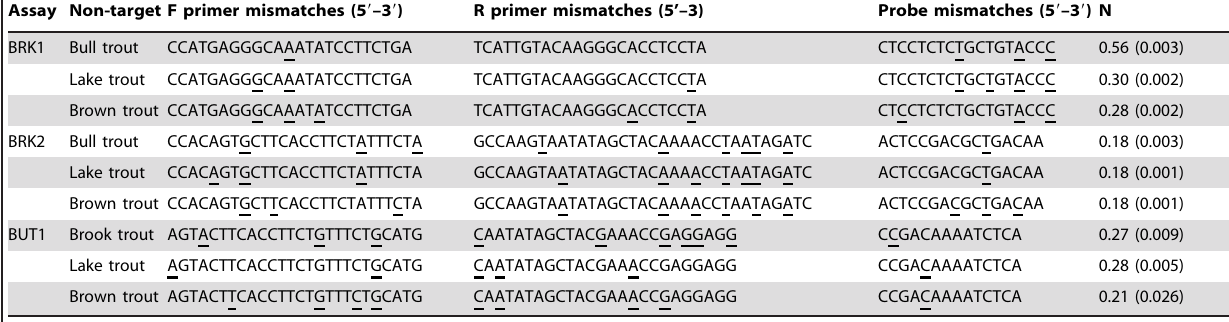
Table 1. Assay sequences and measures of